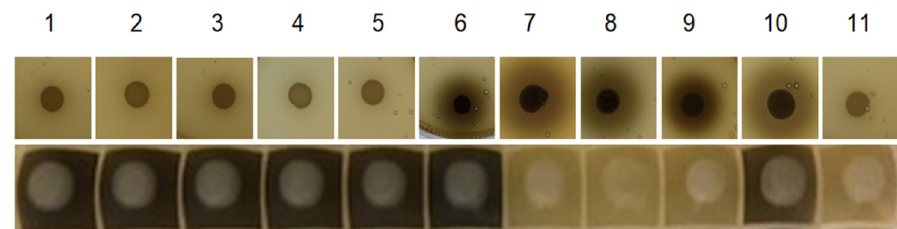
Figure 2. Comparison of esculin-based β -glucosidase activity detection on agar plates and in liquid culture. The β -glycosidic activity of commercial wine yeasts was detected by the occurrence of dark staining after cultivation on esculin-agar plates (top row) and in liquid esculin-containing media (bottom row). Details are described in the material and methods section. 1: Kitzinger Champagner, 2: Kitzinger Portwein, 3: Kitzinger Universal, 4: Kitzinger Bordeaux, 5: Kitzinger Steinberg, 6: Kitz- inger Aromatic, 7: Bioferm Blanc, 8: Bioferm Doux, 9: Bioferm Killer, 10: Bioferm Malic, 11: Bioferm Rouge.